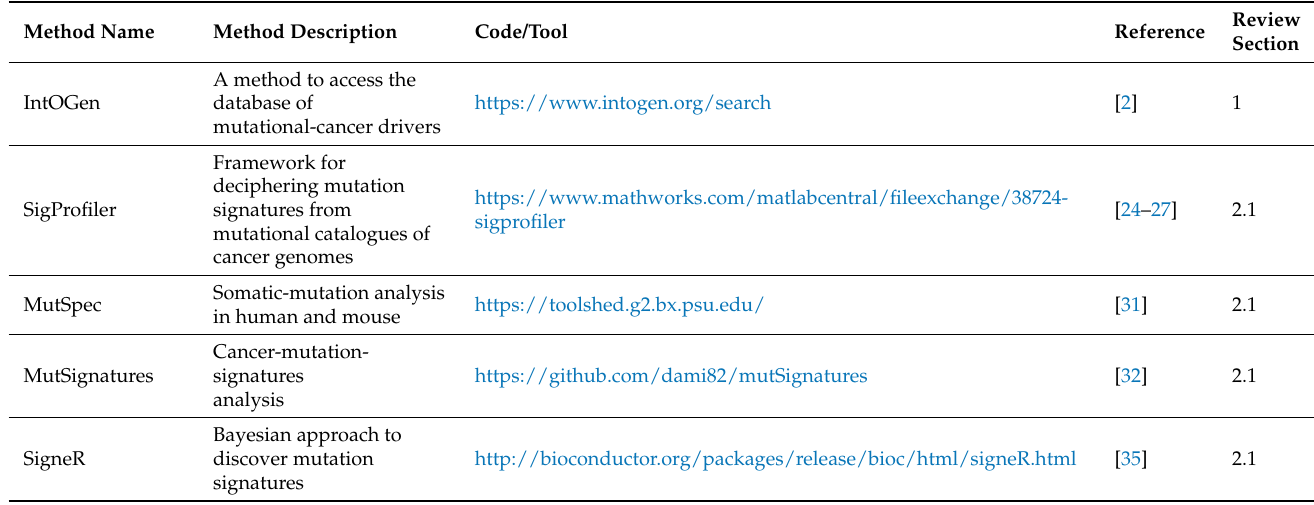
Table 3. Summary of tools reviewed in this article, software resources, and mention of the review section where tools are referenced. All referenced tools and websites were accessed between 16 February 2023 and 19 February